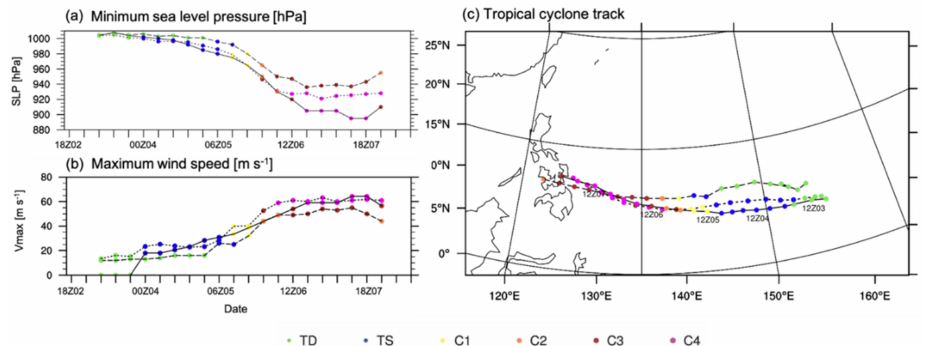
Figure 4. Comparison of ( a ) MSLP, ( b ) maximum surface wind speed, and ( c ) track among the JMA typhoon center best-track data (solid line), nature run (dotted line), and control run (dashed line). The color of dot represents each stage of the storm; tropical disturbance (TD; green), tropical storm (TS; blue), Saffir–Simpson category 1 (C1; yellow), category 2 (C2; orange), category 3 (C3; brown), and category 4 (C4; purple).